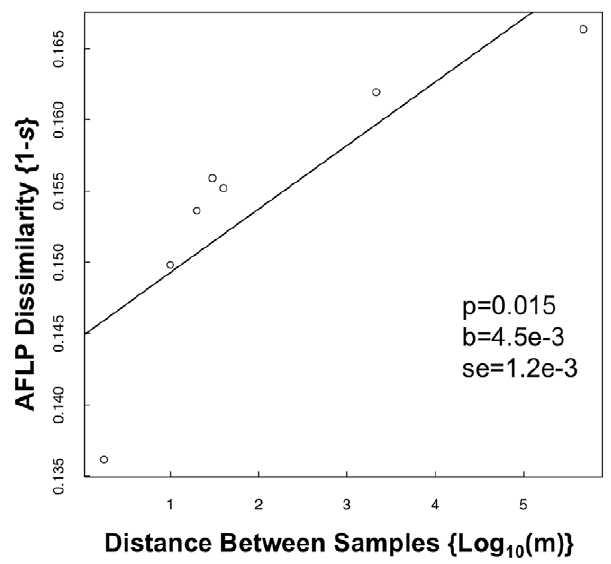
Figure 4. AFLP dissimilarity by geographic distance. Points from left to right are plotted at 1.8 m (within subgroup), 10 m (between adjacent subgroups), 20 m, 30 m, 40 m, 2139 m (between transects), and 473,025 m (between prairies). The slope parameter (‘b’), and 95% confidence interval from a randomization test are indicated.